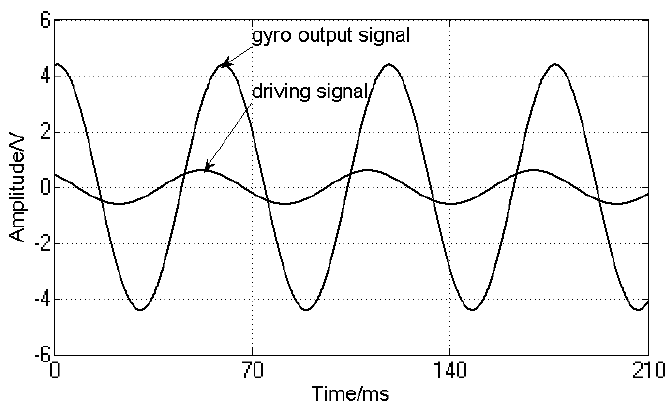
Figure 17. Dynamic simulation